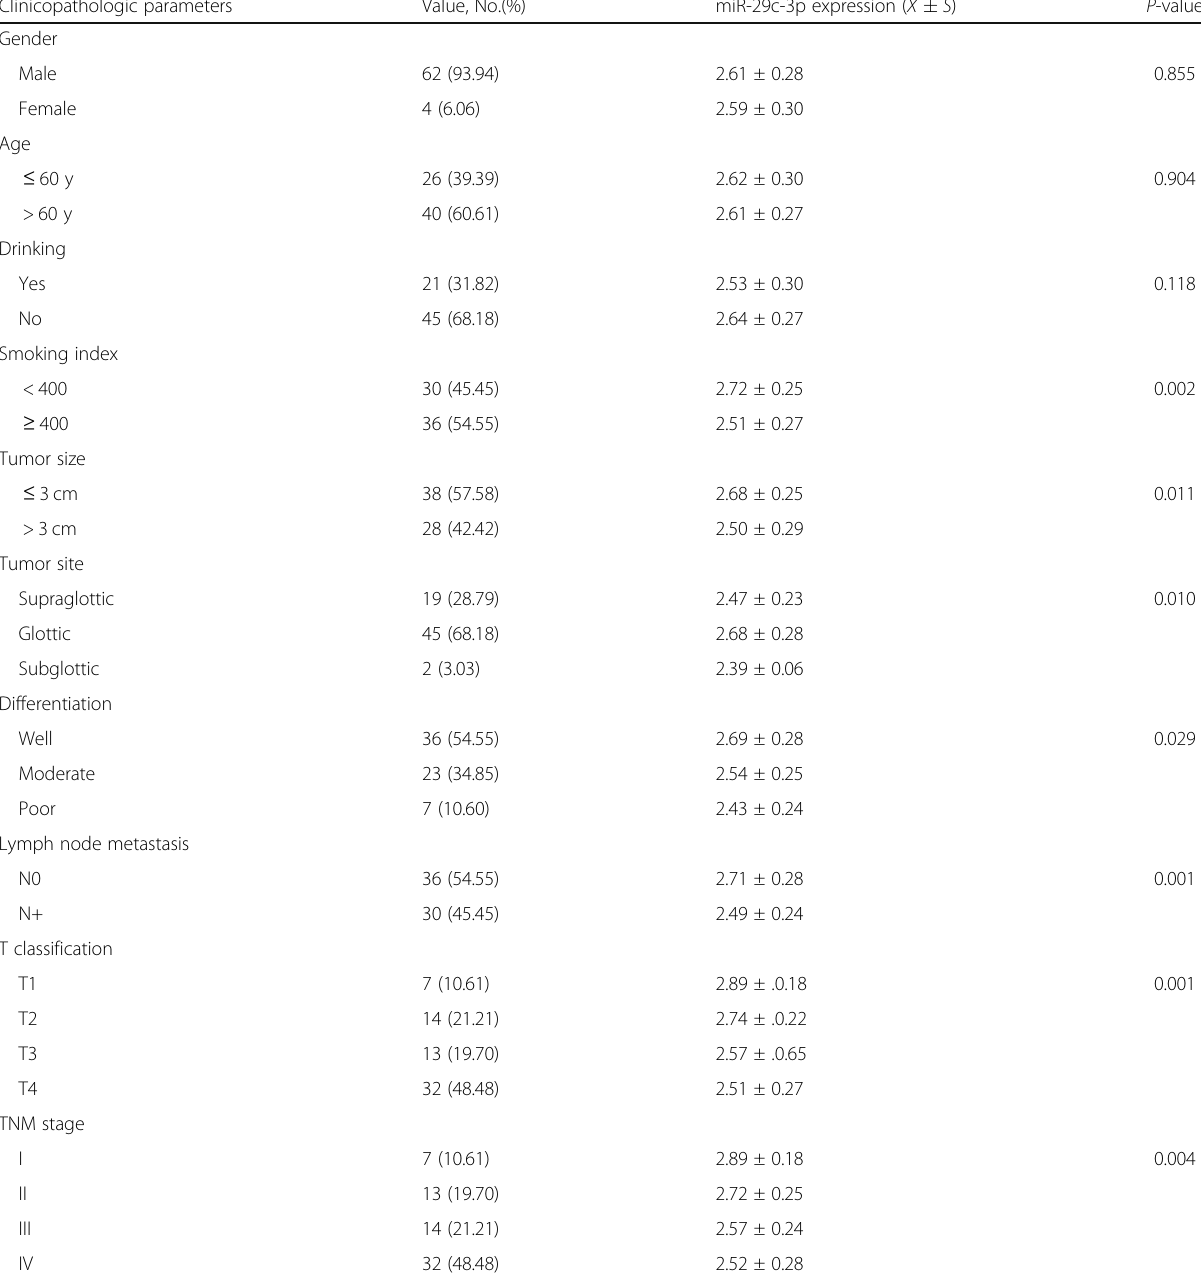
Table 1 Relationship between miR-29c-3p and clinicopathological parameters in 66 patients with LSCC Clinicopathologic